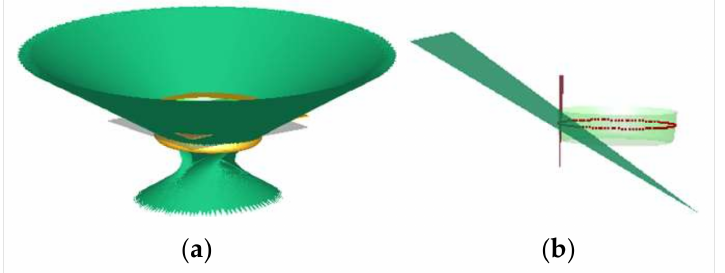
Figure 15. Rotation of the vertical plane: ( a ) the plane after rotation; ( b ) the single plane of rotation. Figure 16a shows the rotated planes that are intersected with the upper and lower cutting surfaces, and Figure 16b shows cutting